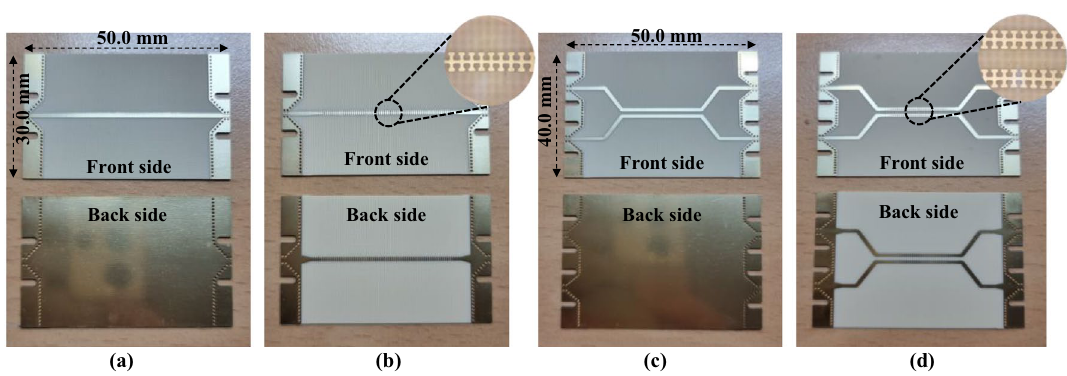
Figure 6. Design of microstrip-to-DS SSPP transition. ( a ) Dispersion curves at different positions along transition. ( b ) Simulated S -parameters of back-to-back transition.